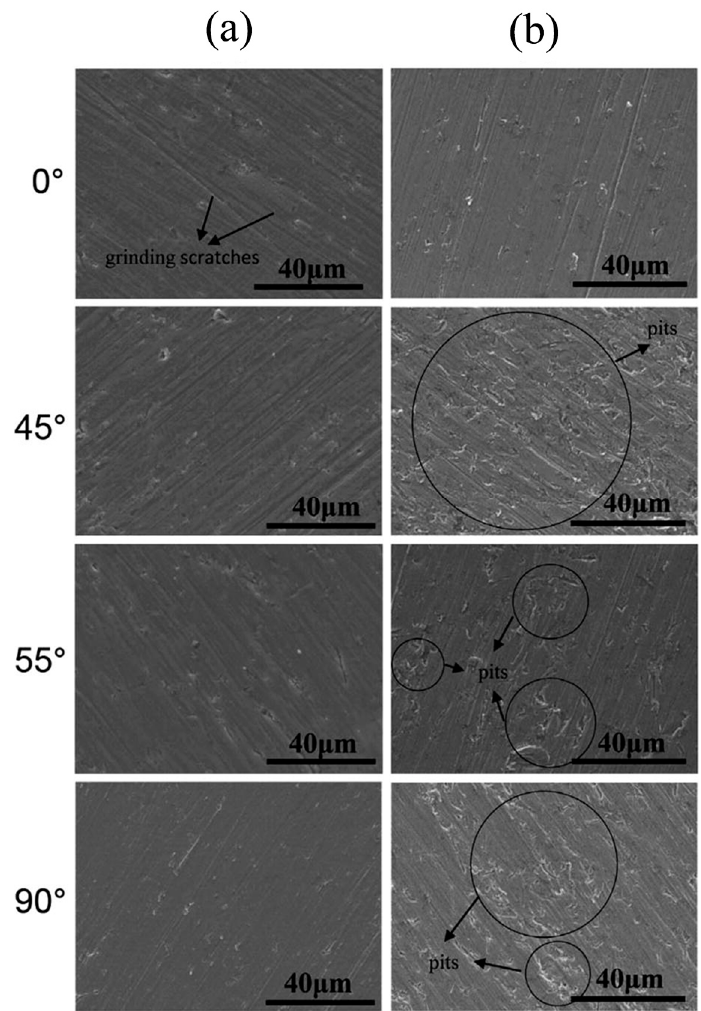
Figure 5. Surface morphology of EBM-built Ti-6Al-4V with different building planes in 1 M HCl solution ( a ) before corrosion test, and ( b ) after corrosion test. Reprinted with permission from ref. [92]. Copyright 2021 Elsevier.